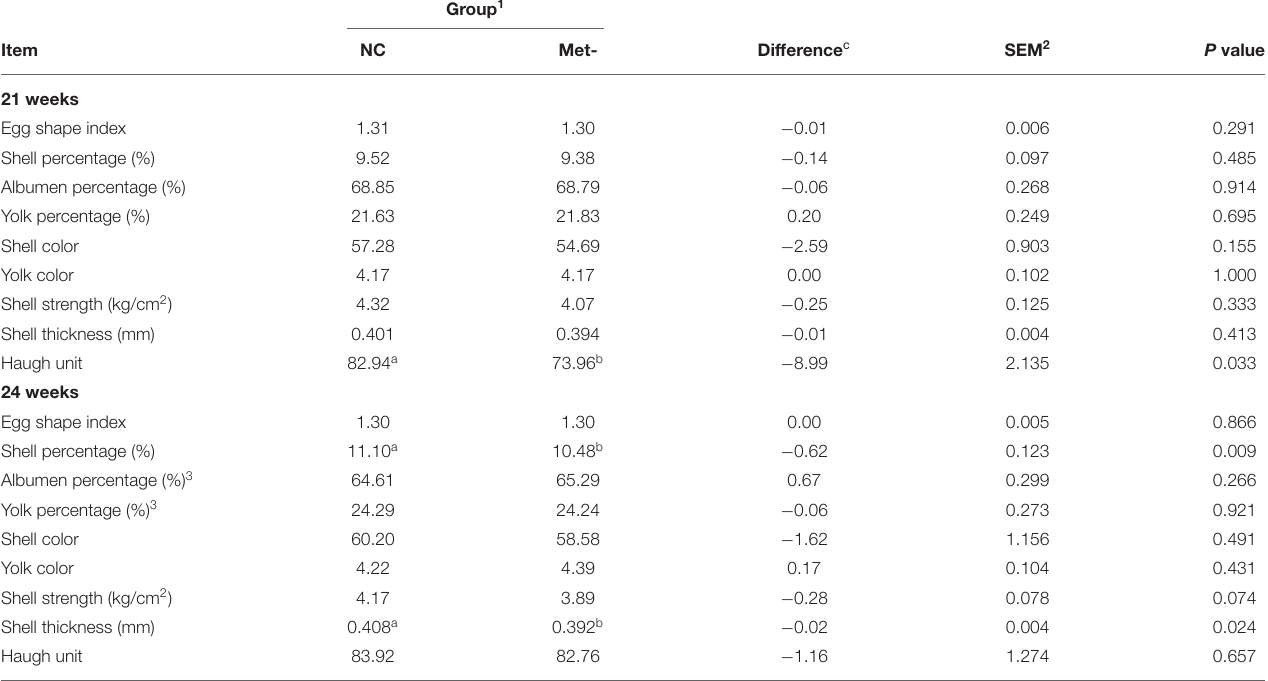
TABLE 5 | Effects of Met deficiency in rearing period diets on egg quality of 21 and 24 weeks laying